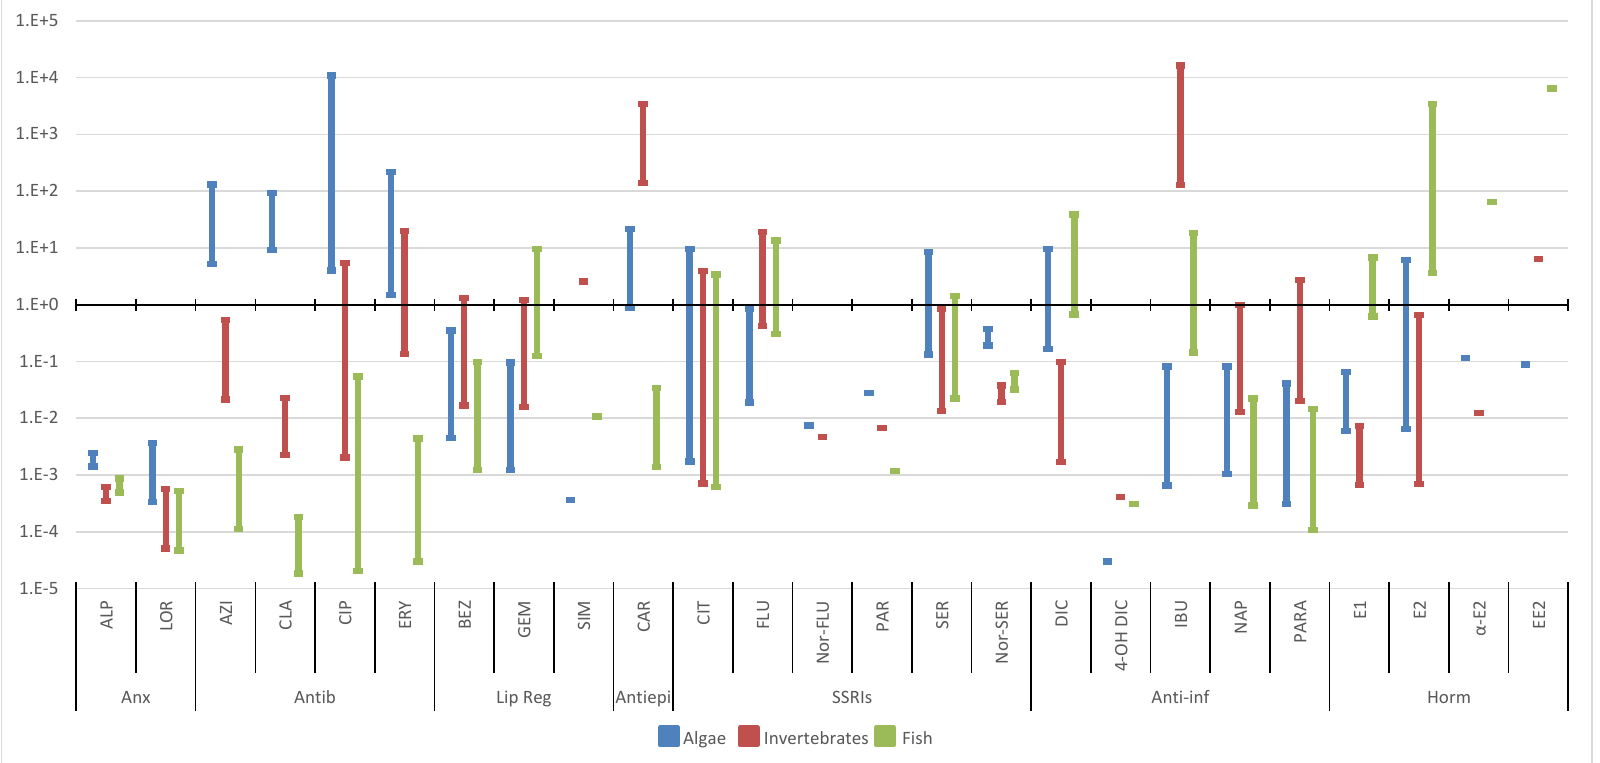
Figure 6. Median and maximum risk quotients of pharmaceuticals in surface waters for the three trophic levels. (Anx—anxiolytics; Antib—antibiotics; Lip reg—lipid regulators; Antiepi—antiepileptics; SSRIs—Selective serotonin reuptake inhibitors; Anti-inf—anti-inflammatories;